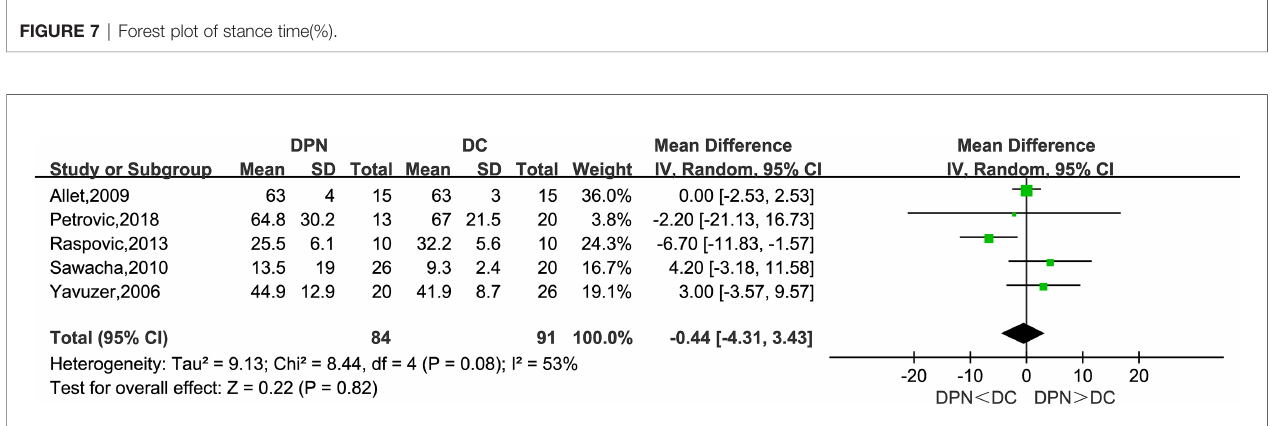
FIGURE 8 | Forest plot of RoM of knee in sagittal plane(°).